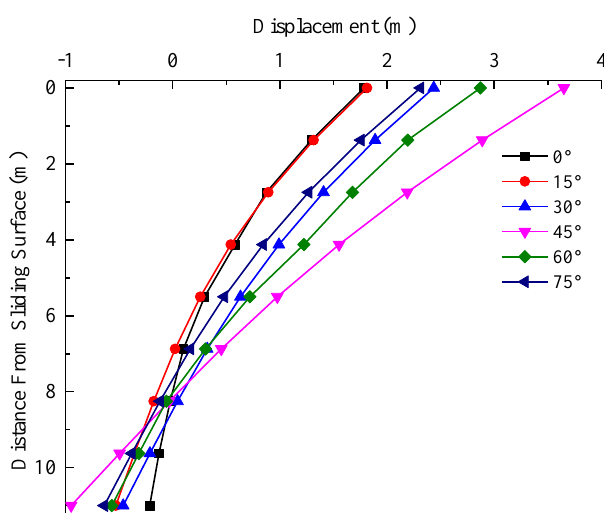
Figure 18. Bending moment distributions along the embedded section of the stabilizing pile.